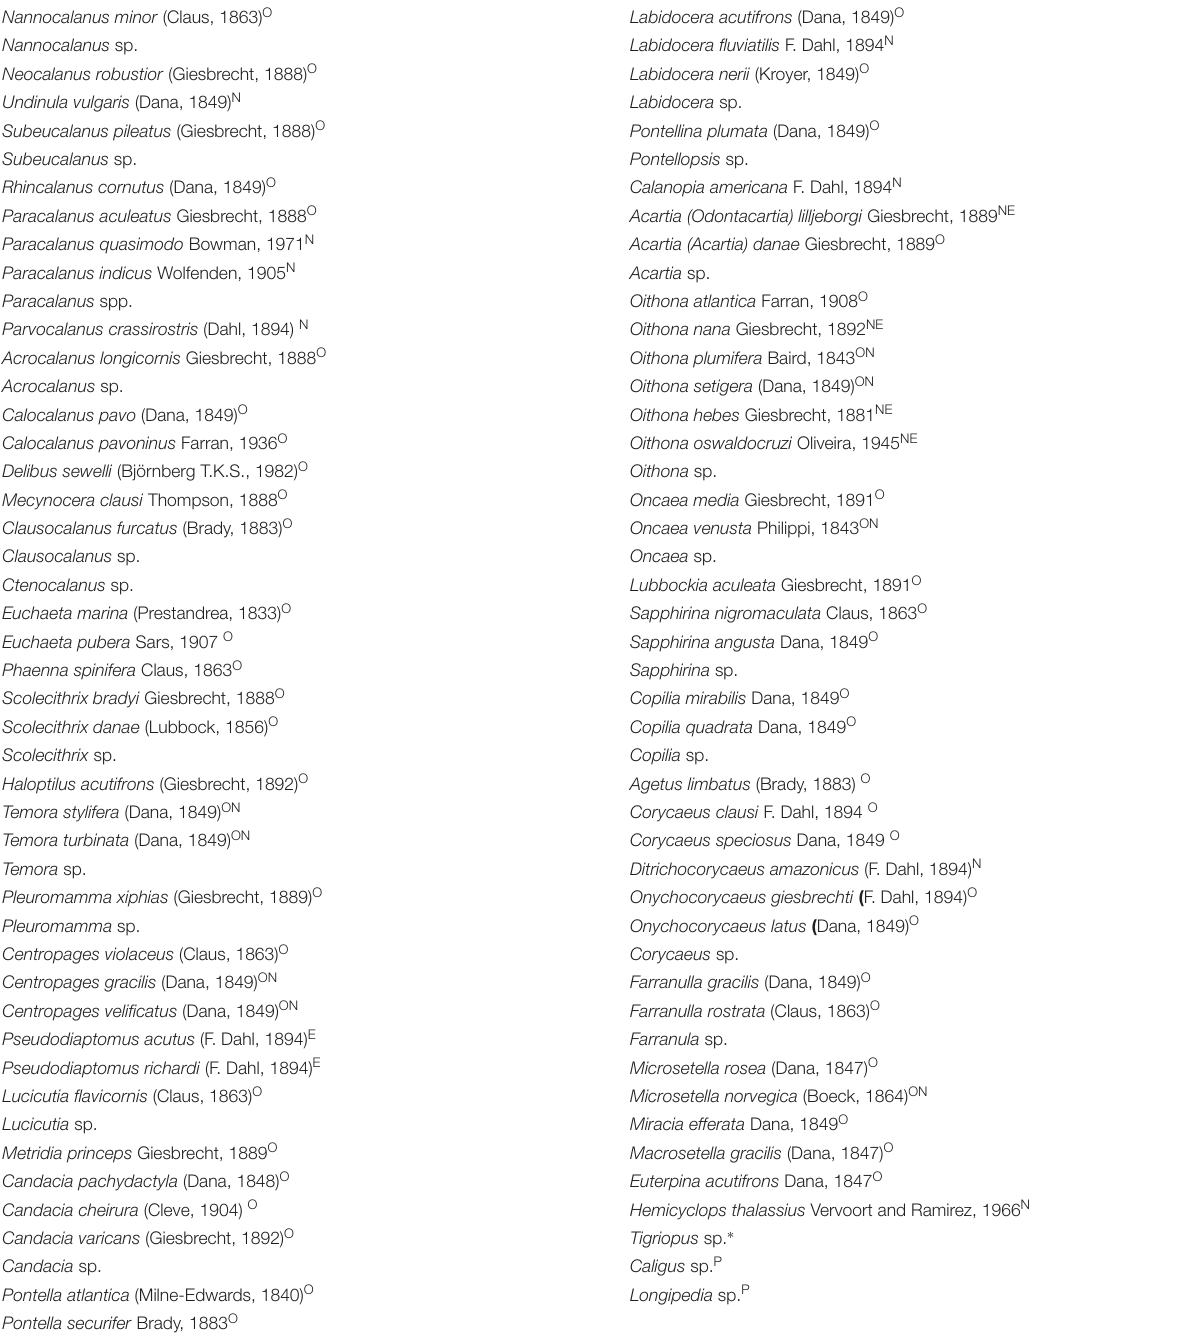
TABLE 2 | List of Copepoda species from coastal and oceanic areas of Rio Grande do Norte, Northeastern Brazil. Nannocalanus minor (Claus, 1863) O